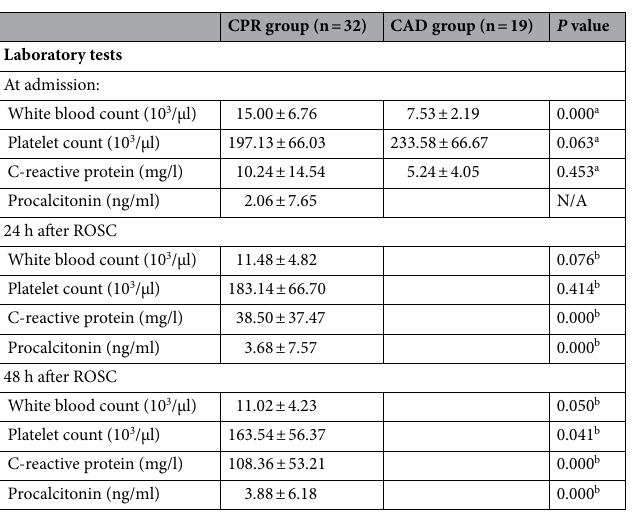
Table 3. Laboratory tests. Shown are the patients’ inflammation blood tests at the time of admission, as well as 24 h and 48 h after ROSC. CPR cardiopulmonary resuscitation, CAD coronary artery disease. a CPR group at admission versus CAD group. b CPR group versus CPR group at admission.